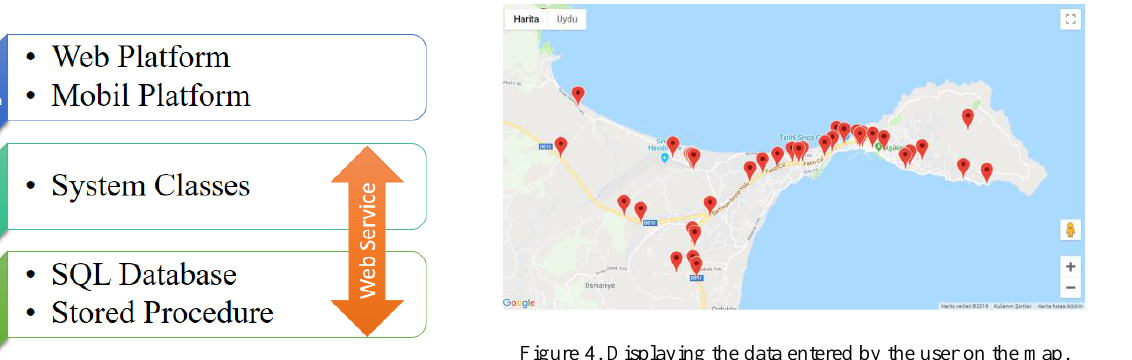
Figure 4. Displaying the data entered by the user on the map.